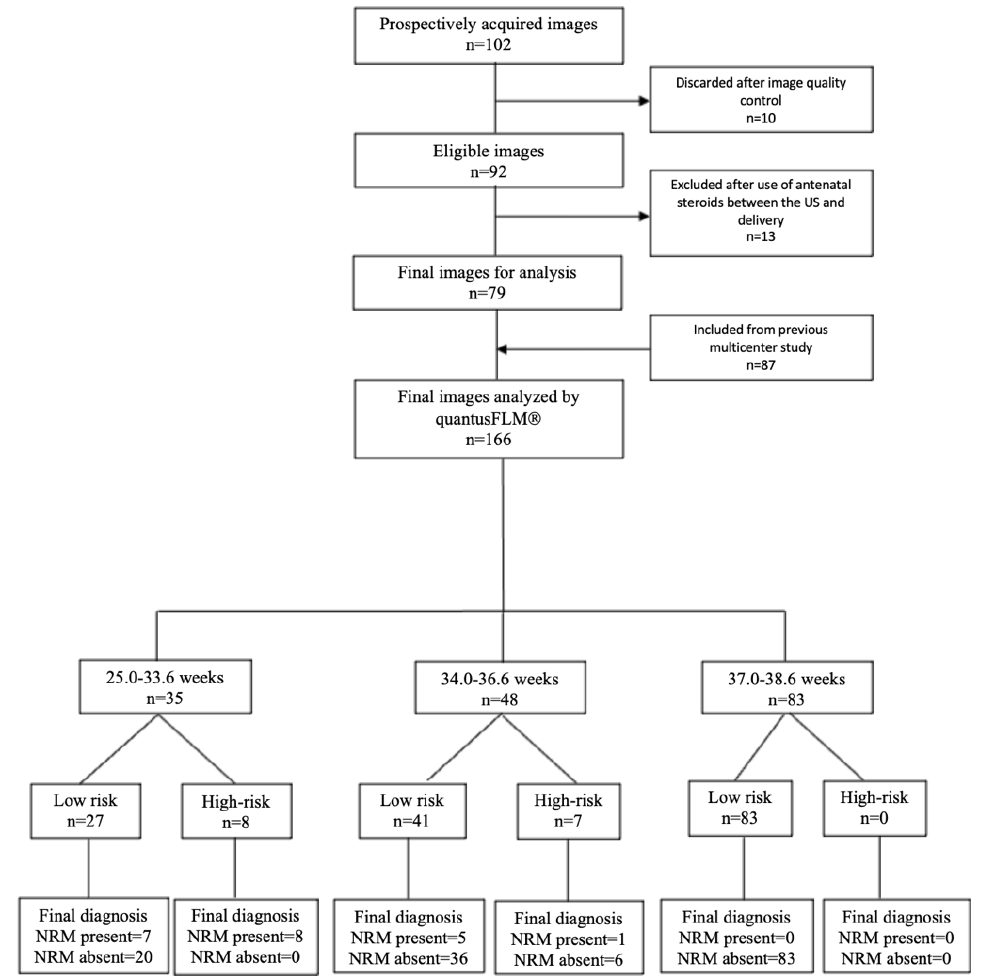
Figure 1. Flowchart of the eligible cases according to STARD guidelines.